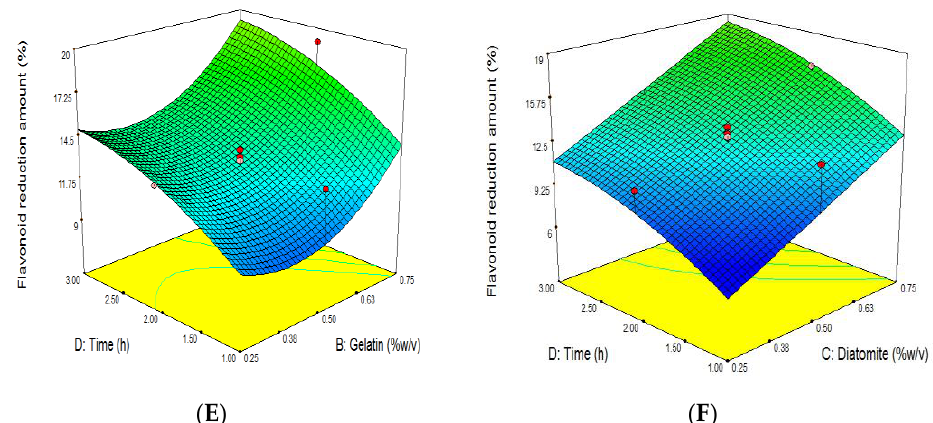
Figure 3. Response surface plot of the effects of bentonite, gelatin, and diatomite concentration and clarifying time on flavonoid reduction amount (%) of grape juice. Influence of ( A ): gelatin and bentonite, ( B ): diatomite and bentonite, ( C ): time and bentonite, ( D ): diatomite and gelatin, ( E ): time and gelatin, ( F ) : time and diatomite, on grape juice’s flavonoid reduction amount (%).